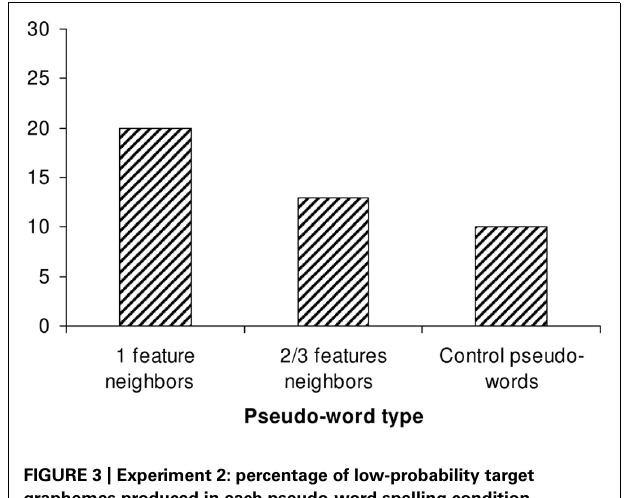
FIGURE 3 | Experiment 2: percentage of low-probability target graphemes produced in each pseudo-word spelling